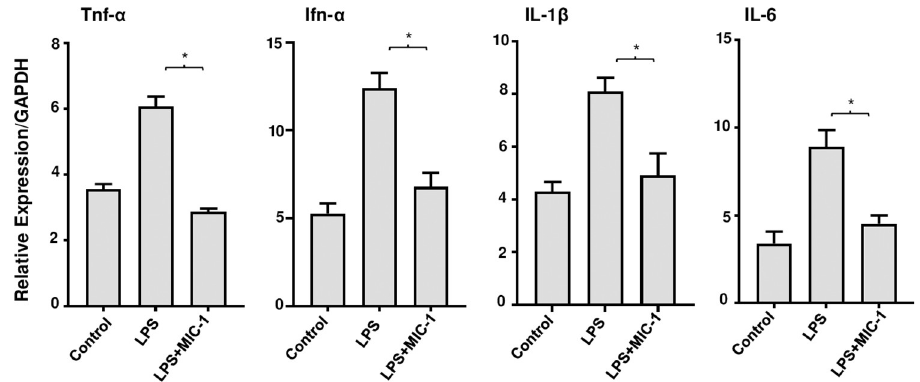
Fig 4. Moringa isothiocyanate-1 (MIC-1) reduced lipopolysaccharide (LPS)-induced pro-inflammatory markers in muscle tissue. TNF- α , Ifn- α , IL-1 β , and IL-6 mRNA levels in the gastrocnemius muscle tissues treated with LPS and/or MIC-1 were measured by RT-qPCR. Data are represented as mean ± S.D. (n = 3). � P < 0.05, obtained by t-test when compared to LPS-treated group.